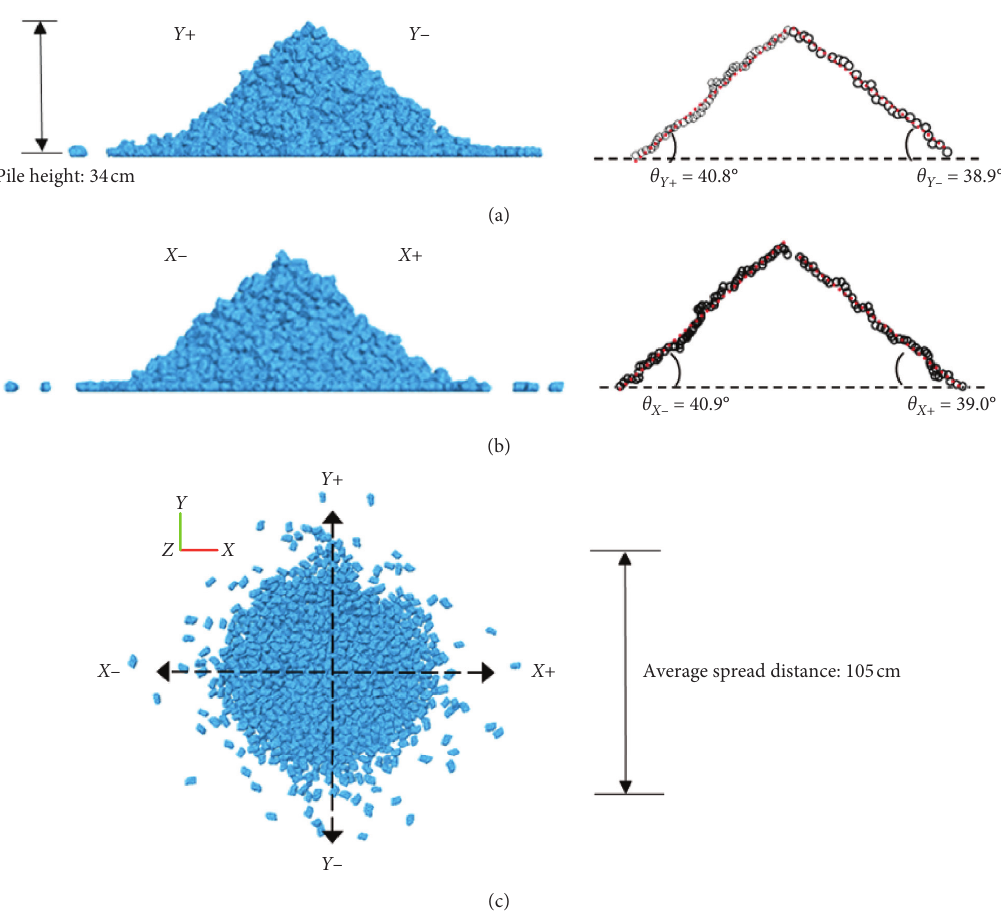
Figure 8: The ballast heap using realistic particles. (a) Side view. (b) Front view. (c) Plan